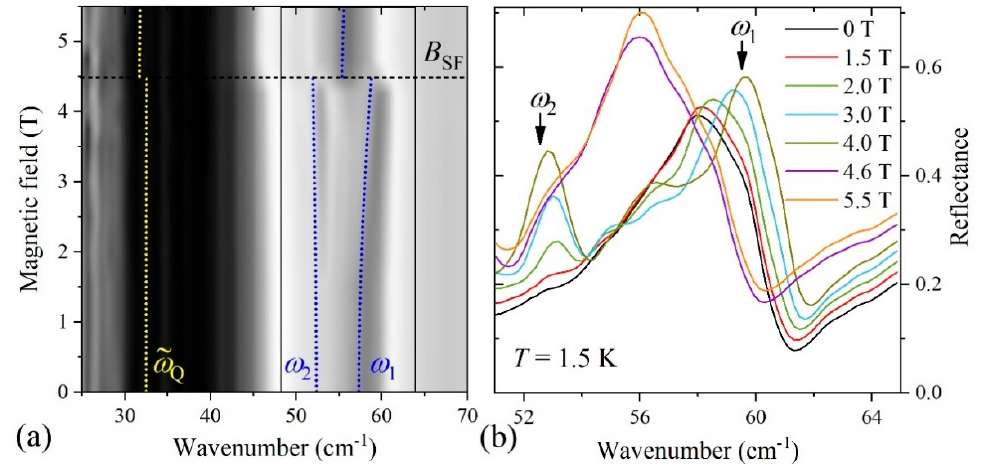
Figure 1. The π -polarized far-infrared reflection spectra of PrFe 3 (BO 3 ) 4 at T = 1.5 K in the external magnetic field B ∥ c ( a ) represented as a reflection intensity map [black (white) color corresponds to the reflectance close to unity (zero)] in the frequency—magnetic field axes and ( b ) for several selected values of B in the region shown by a rectangle in ( a ). The spin-flop transition in the field B SF ≈ 4.5 T is clearly observed in the spectra. Dotted lines in ( a ) represent the calculated transverse optical (TO) frequencies of the quasi-phonon ( (cid:101) ω Q ) and two quasi-electronic branches ( ω 1 and ω 2 ) of the coupled mode (see the text).